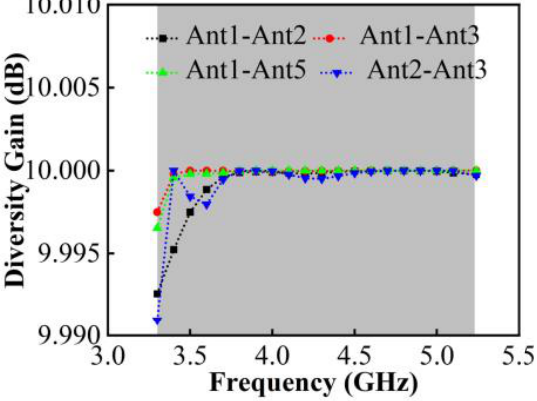
Figure 16. Calculated DG. Figure 17 indicates the total efficiency of single antennas, which is above 50% and can reach up to 89%. From there, the MIMO antenna system carries spatial multiplexing and diversity techniques to improve the transmission rate, and its ports multiplexing efficiency can be calculated by Equation (3).